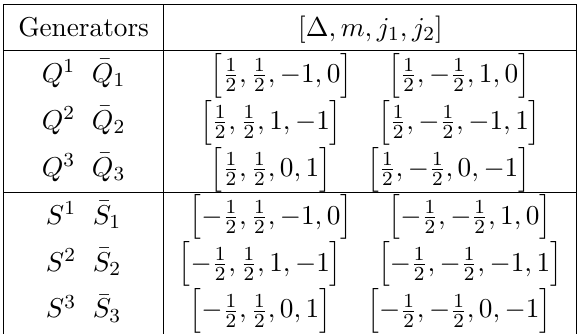
Table 2. Table of Dynkin labels of fermionic generators. For a generic element v µ transforming in a weight- µ representation, the Dynkin label corresponding to a generator H i of the Cartan subalgebra is defined as j i ( v µ ) ≡ 2[ H i , v µ ] .